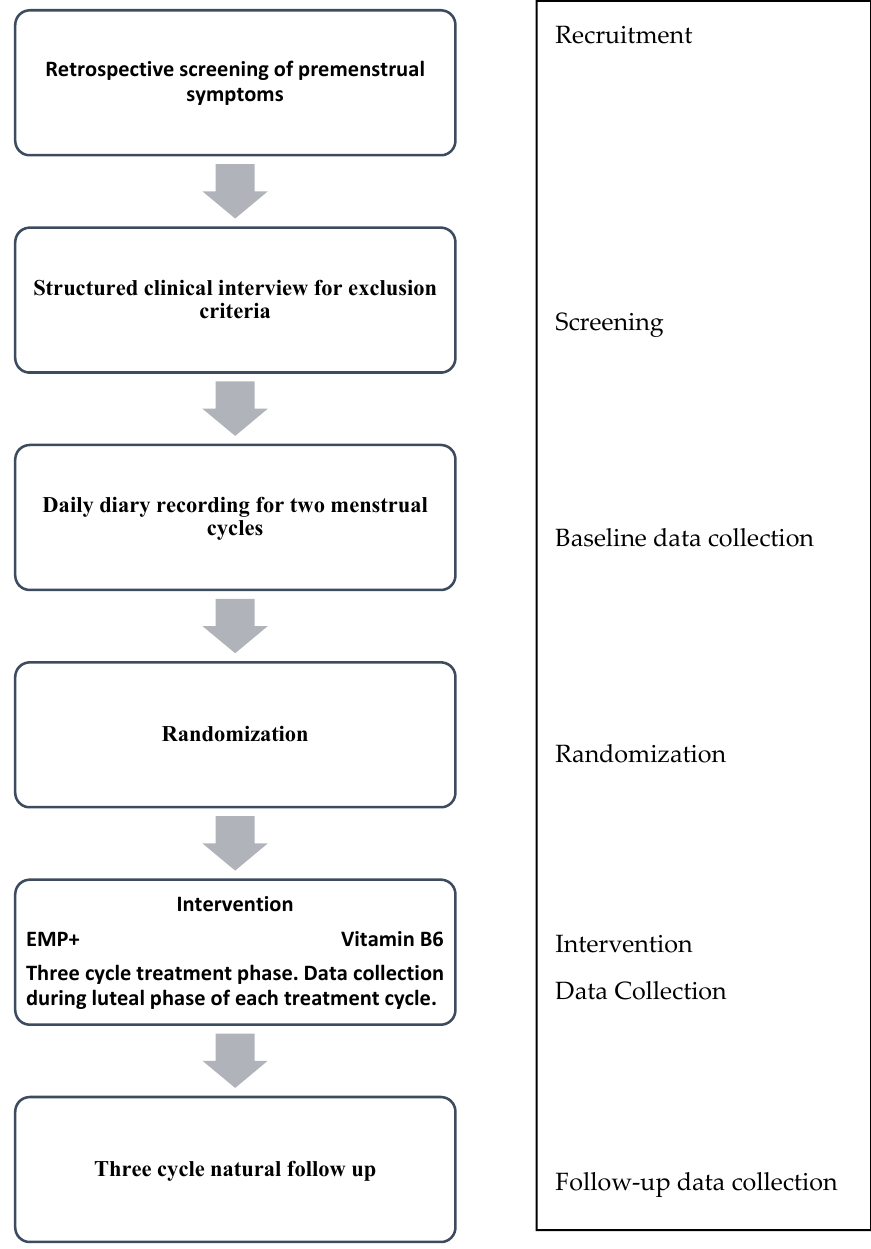
Figure 1. Study Figure 1. Study Process.